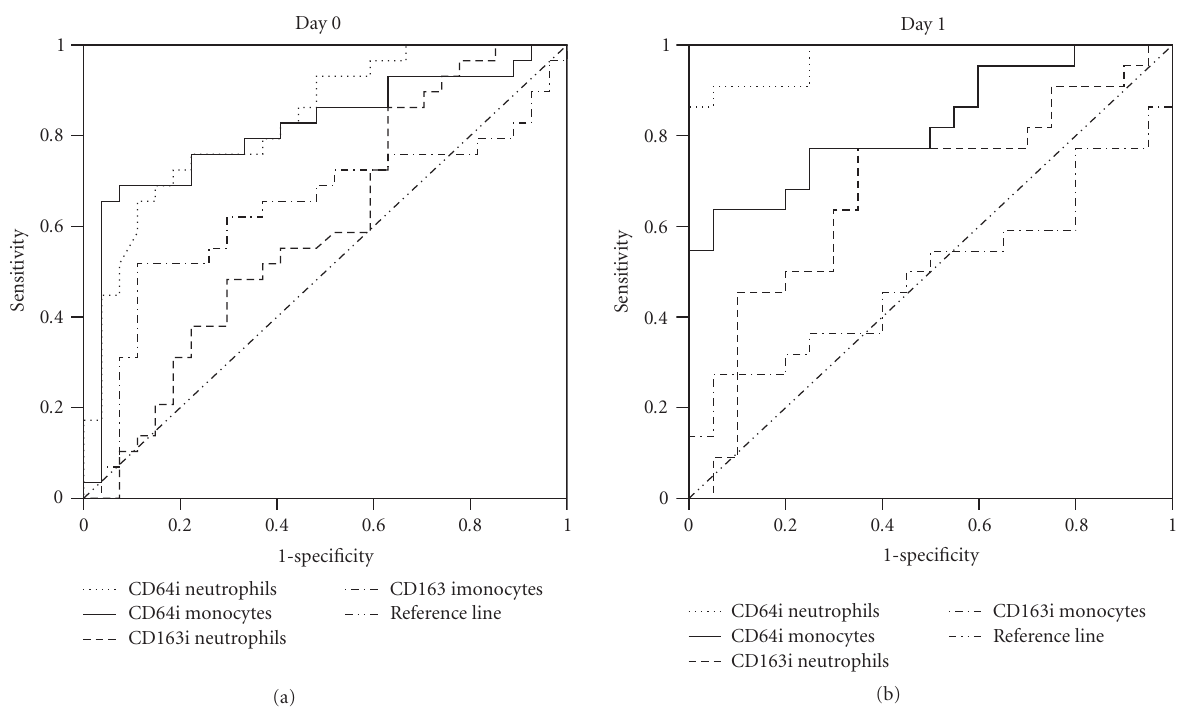
Figure 3: Receiver-operating characteristic (ROC) curves of CD64 and CD163 indexes (i) for neutrophils and monocytes for critically ill neonates and children with SIRS with sepsis and SIRS without sepsis at the time of suspected sepsis (day 0) and 24 hours later (day